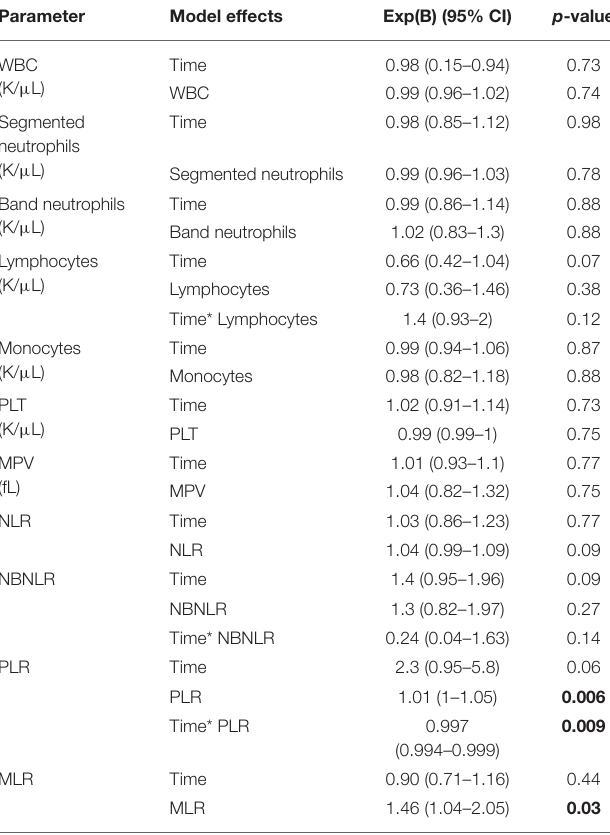
TABLE 3 | Parameters estimates in GEE models of septic